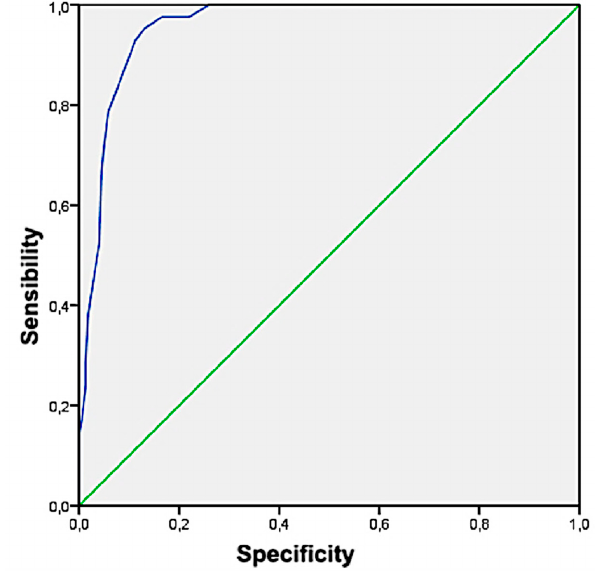
Figure 4 . NIM-MetS Model 1 by discriminant analysis.